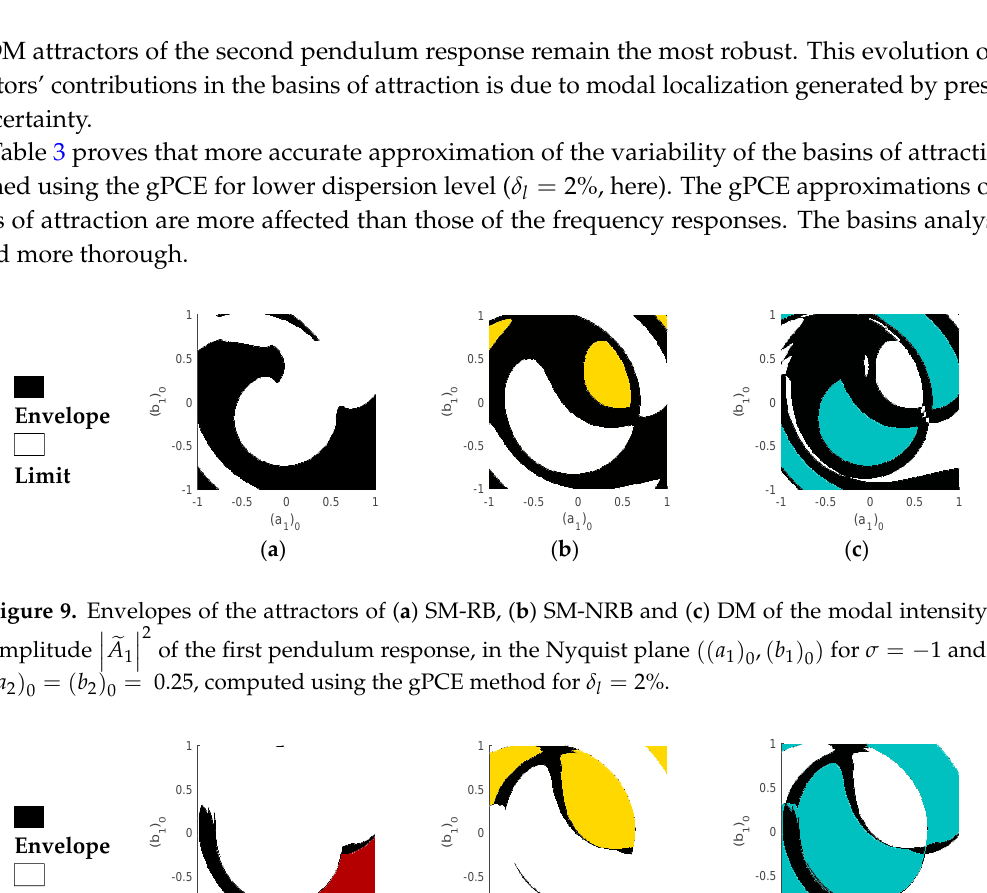
) for σ = − 1 and , ( b 1 ) 0 0 = 5%. l